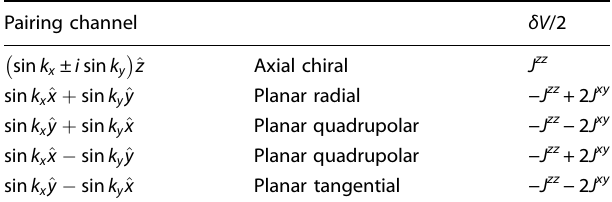
Table 2. Relative change in pairing interaction for spin-triplet pairing channels due to Ising and compass exchange terms Pairing channel